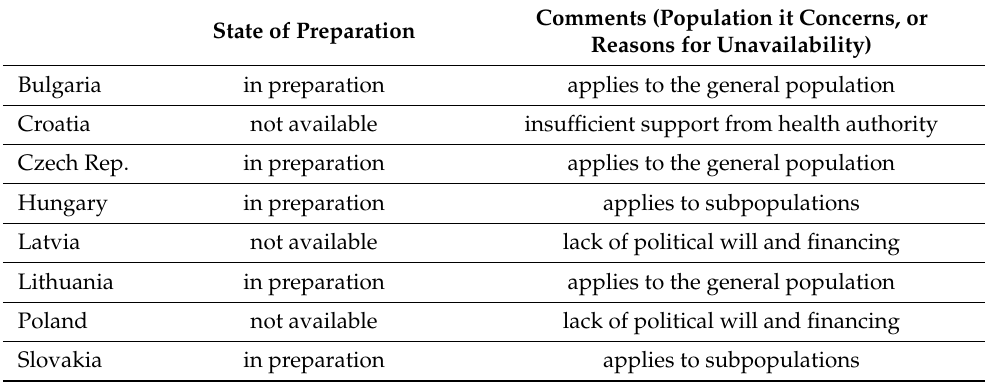
Table 3. Availability of national screening programs in particular countries. Comments (Population it Concerns, State of Preparation